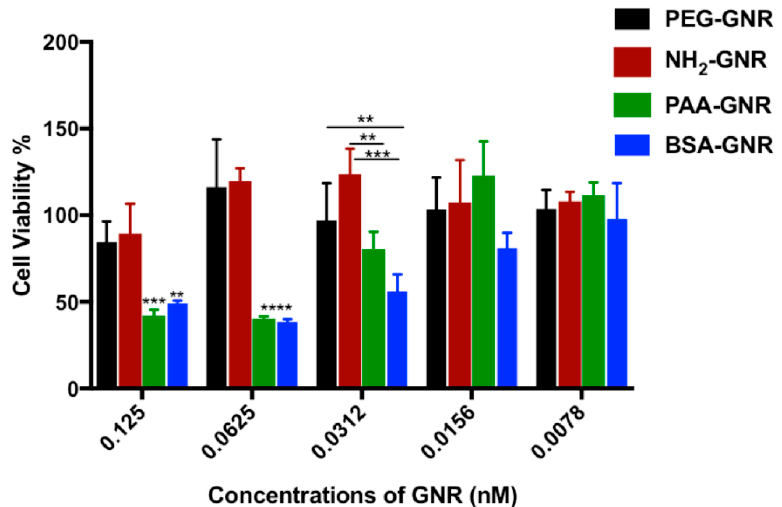
Figure 2. Cellular viability percentages of GNR of different surface modifications against human dermal fibroblasts. Anionic charged- and BSA-conjugated GNR demonstrated the highest cytotoxicity against human dermal fibroblasts. Data are presented as mean ± SD. One-way ANOVA was used to estimate the statistical differences; ** p < 0.01, *** p < 0.001 and **** p < 0.0001.